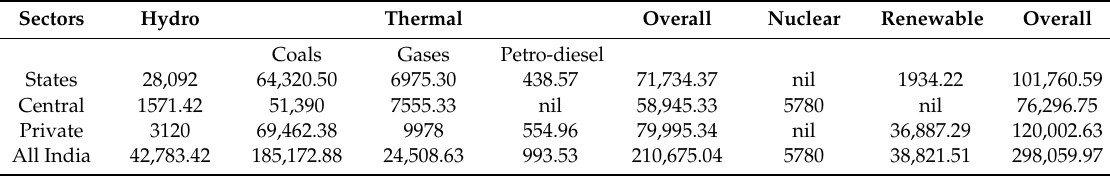
Table 3. Sector-specific installed capacity in megawatts for di ff erent plants in India by the year 2016 [10]. Sectors